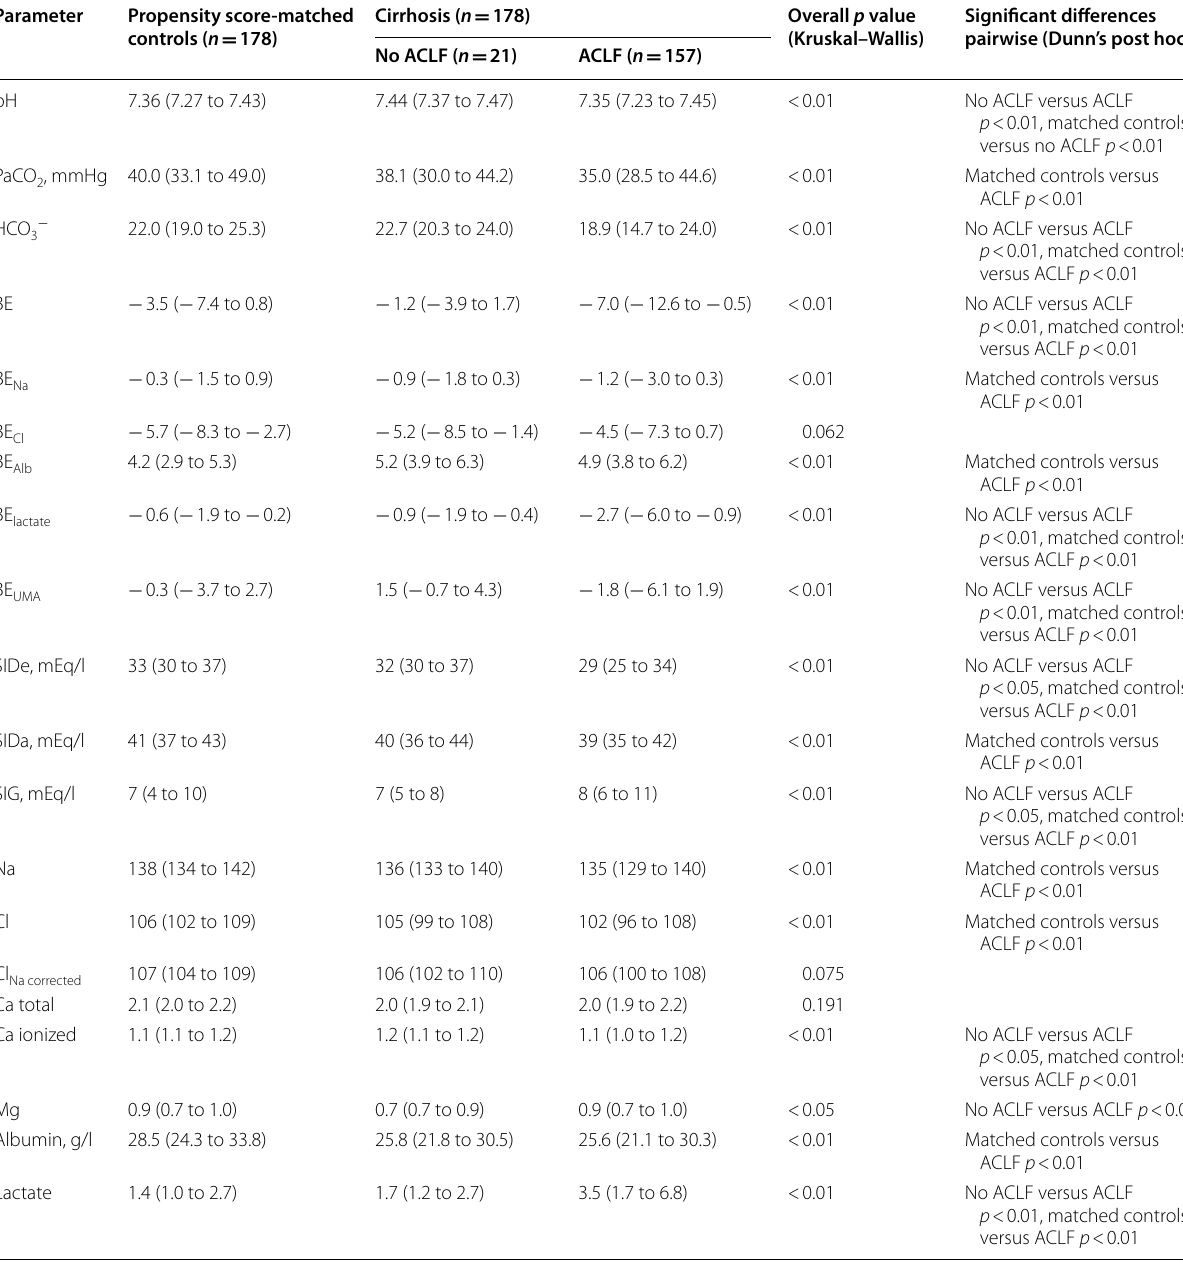
Table 2 Acid–base parameters of critically ill patients with and without liver